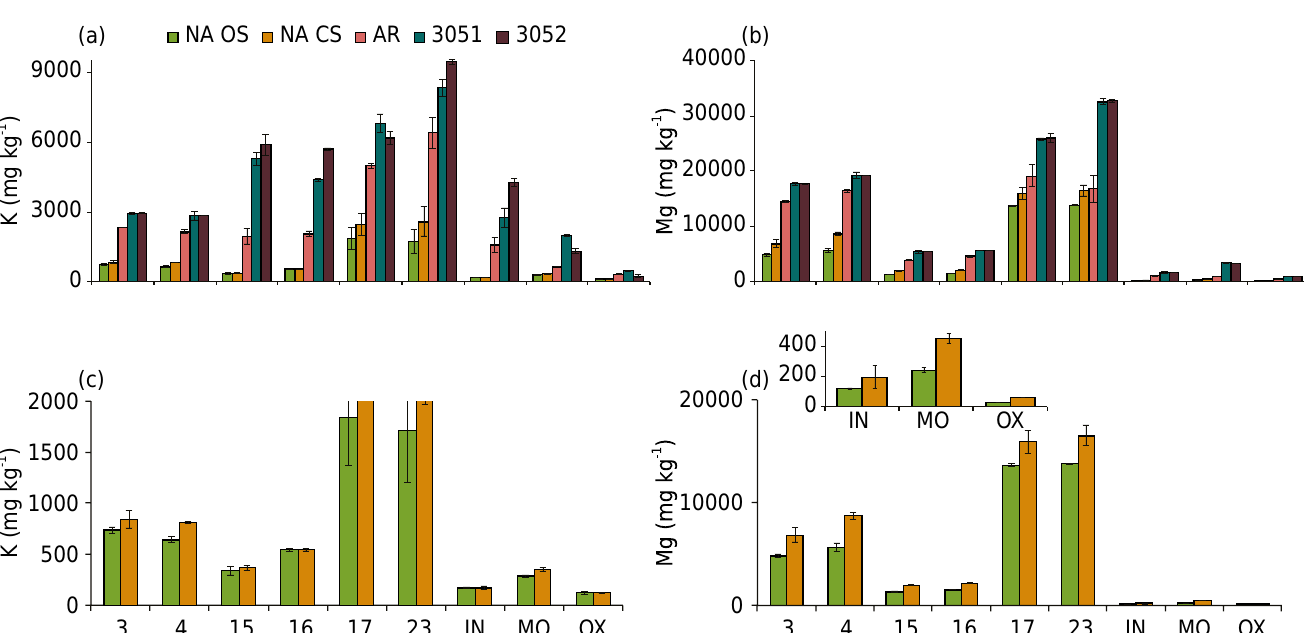
Figure 3. Contents of K and Mg clay fraction extracted by different acid extractants: nitric acid in an open system (NA OS), nitric acid in a closed system (NA CS), aqua regia (AR), EPA 3051A (3051), and EPA 3052 (3052). The last two figures show only extractions and NACS and NA OS to allow better comparison between open and closed extraction systems. IN: Inceptisol; OX: Oxisol; MO: